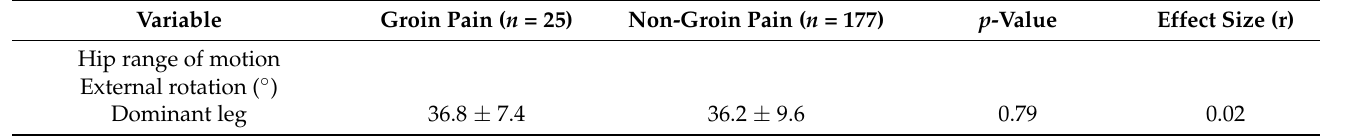
Table 4. Hip range of motion and strength in the presence or absence of groin